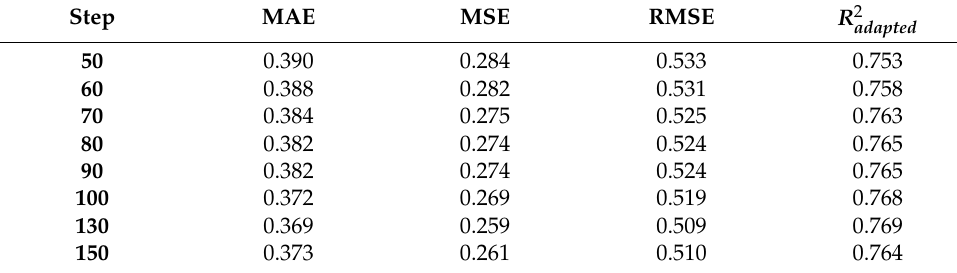
Table 2. FPK-Net model prediction measures under different sliding window lengths.